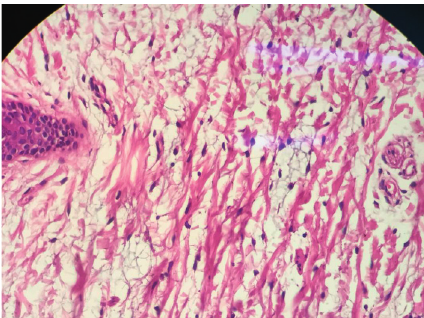
Figure 4: A magnified view of histopathological changes seen in the patient’s tissue